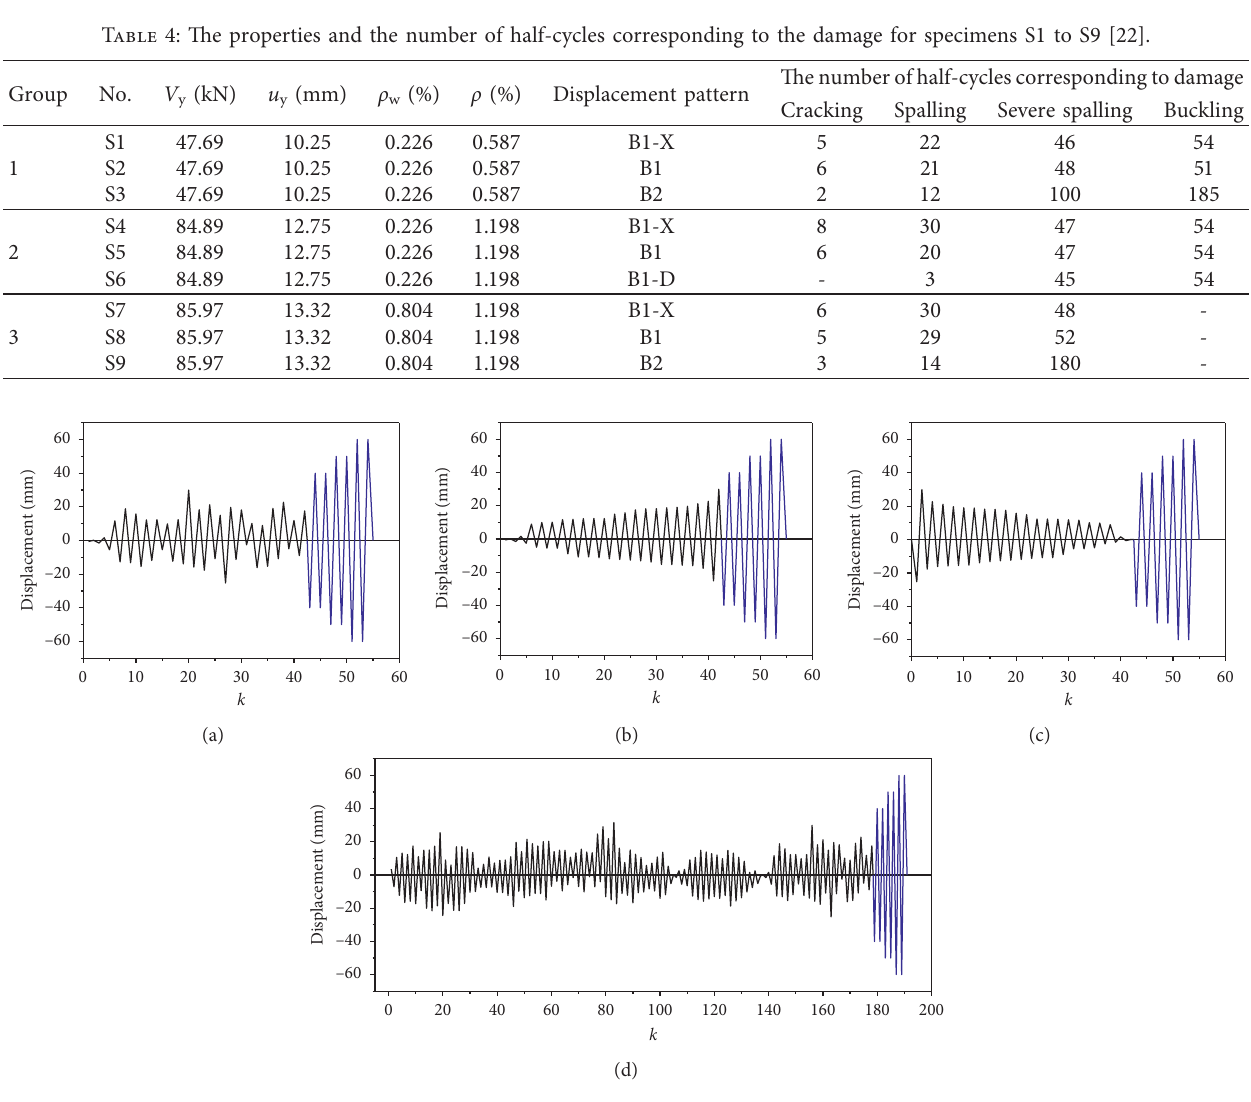
Figure 16: Four displacement patterns imposed on specimens S1 to S9: (a) B1. (b) B1-X. (c) B1-D. (d) B2.